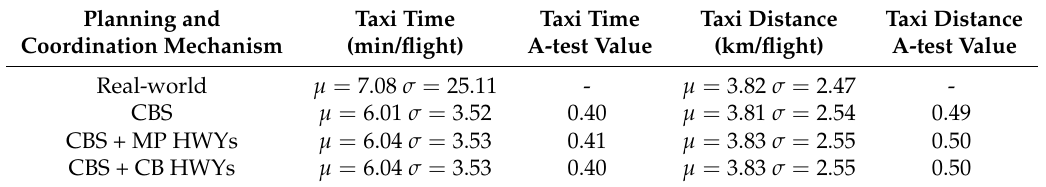
Table 3. MAS simulation average taxi time and taxi distance of flights on all days.